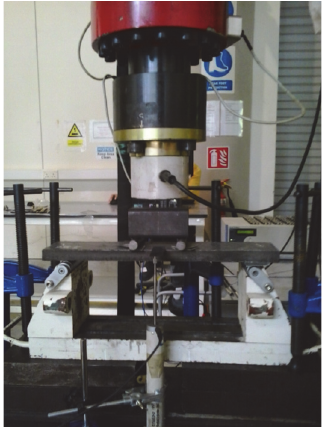
Figure 1: Flexural test for ECC.